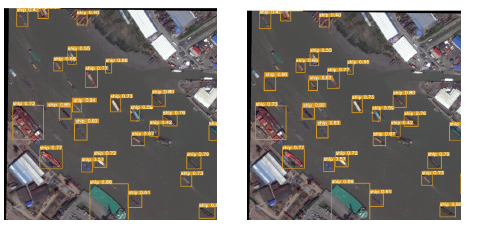
Figure 14. The first group effect is shown.